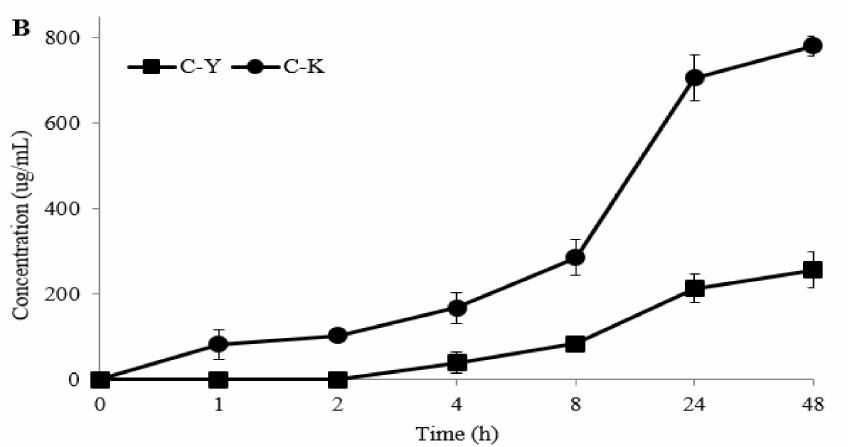
Figure 5. Time course of the biotransformation of total ginsenoside fraction by FFEP. ( A ) relative